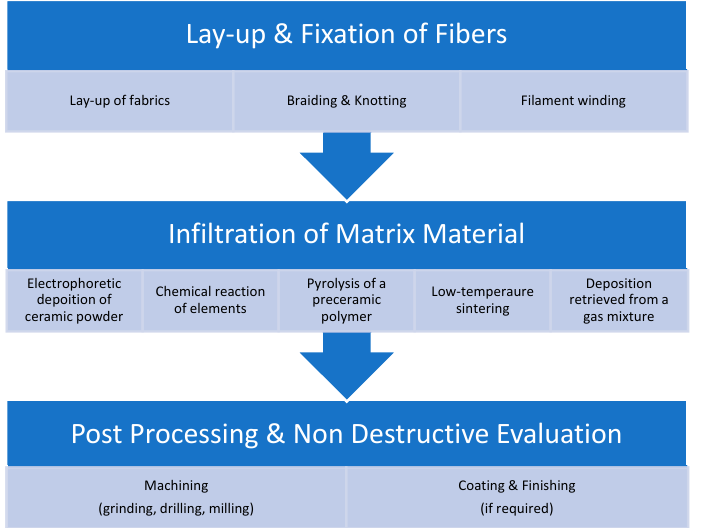
Figure 15. Fabrication procedure steps for CMCs.